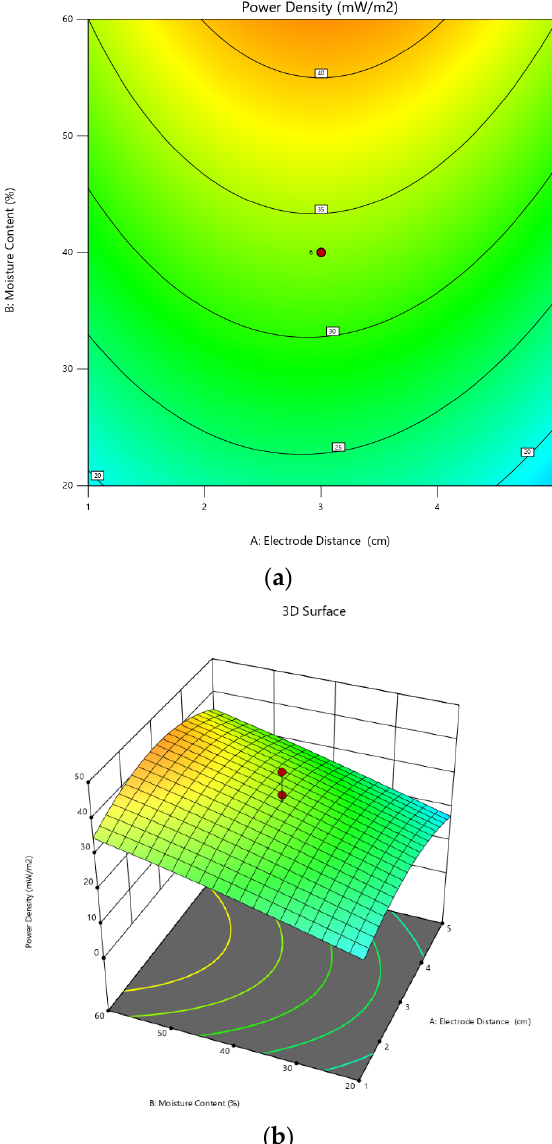
Figure 9. ( a ) Contour plot and ( b ) response surface plot of power density generation as a function of moisture content relative to electrode